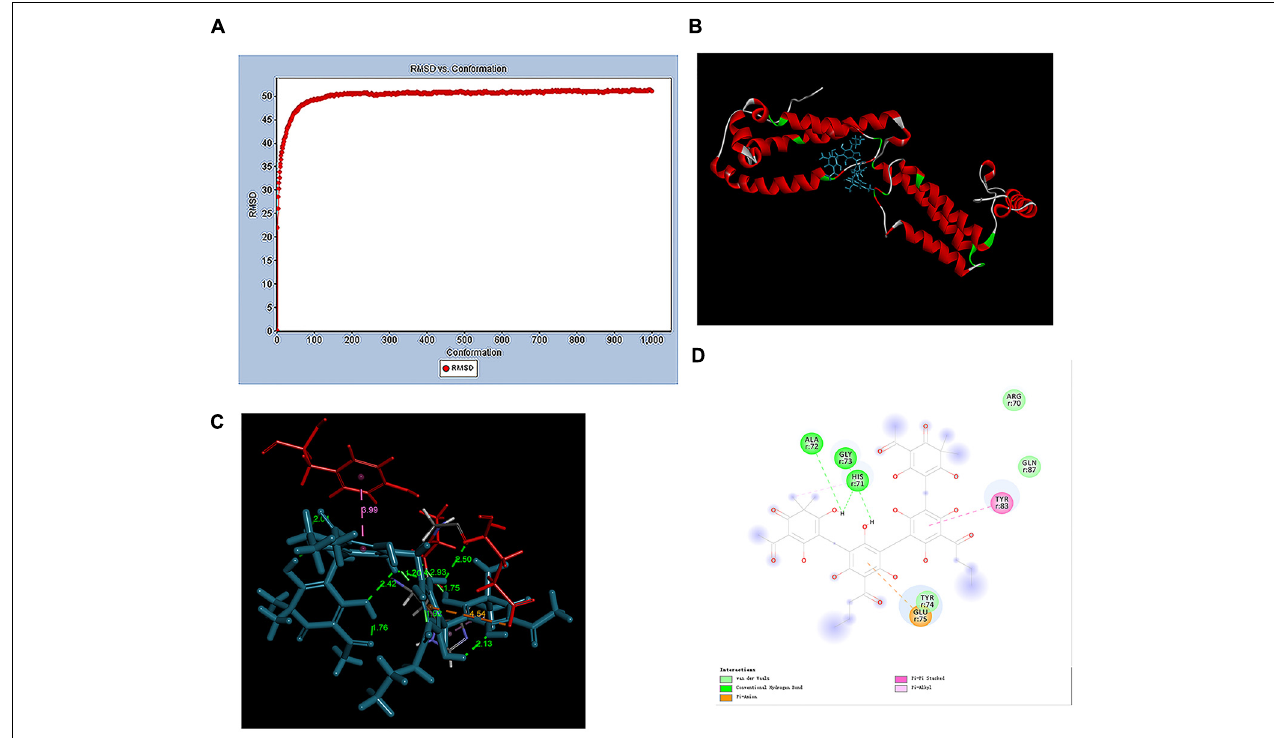
FIGURE 5 | General view of the vWbp-ABBA complex based on MD simulation. (A) RMSD plot for the vWbp-ABBA complex during a 20-ns MD simulation. (B) A binding model of the vWbp-ABBA complex was prepared by using Discovery Studio 2017. (C) Details of the binding model of the vWbp-ABBA complex. (D) A 2D diagram of the vWbp-ABBA complex was prepared by using Discovery Studio